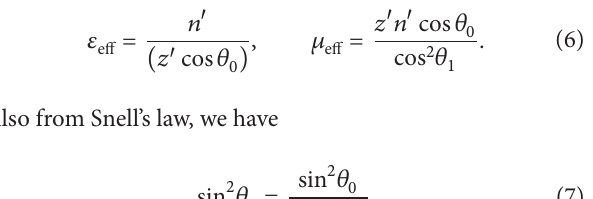
Figure 3: The outermost boundary layer permittivities 𝜀 𝑏1 and 𝜀 𝑏2 of a 5-layer slab versus 𝜀 of the H-model for the 2-layer and 5- eff layer slabs. The field averaging method [21] is applied to compute these curves. As defined in Section 2, 𝑓 20 is the frequency when the in the slab is 20 times the length of the unit effective wavelength 𝜆 eff cell 𝑎 . The quantity 𝑓/𝑓 20 then not only represents frequency, but and 𝑎 . For instance, if also roughly indicates the ratio between 𝜆 eff 𝜆 ≈ 10𝑎 𝑓/𝑓 20 =2, then eff